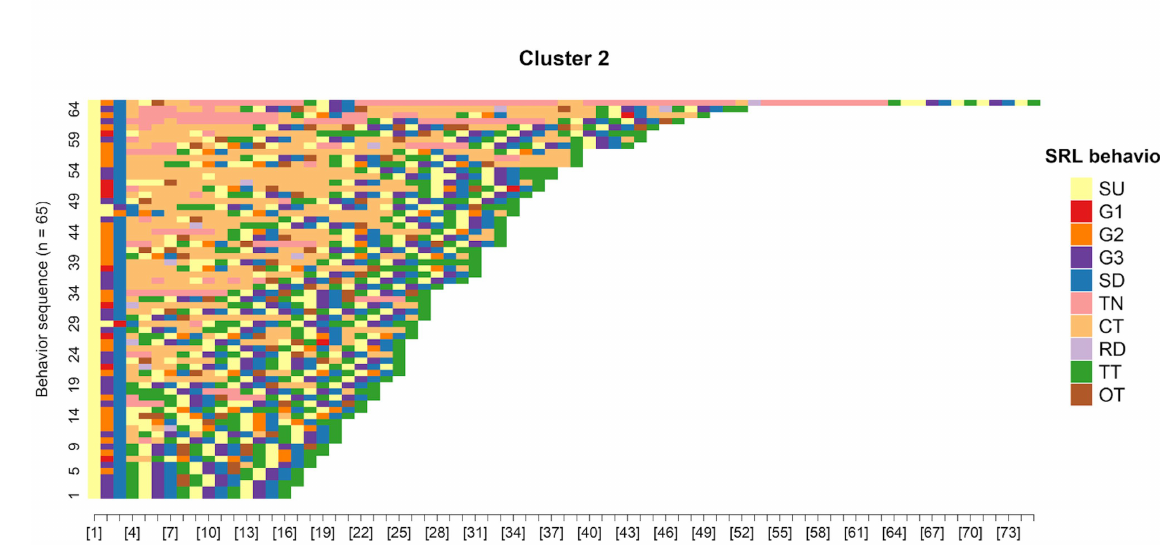
FIGURE 8 Plots of SRL behavior sequences by